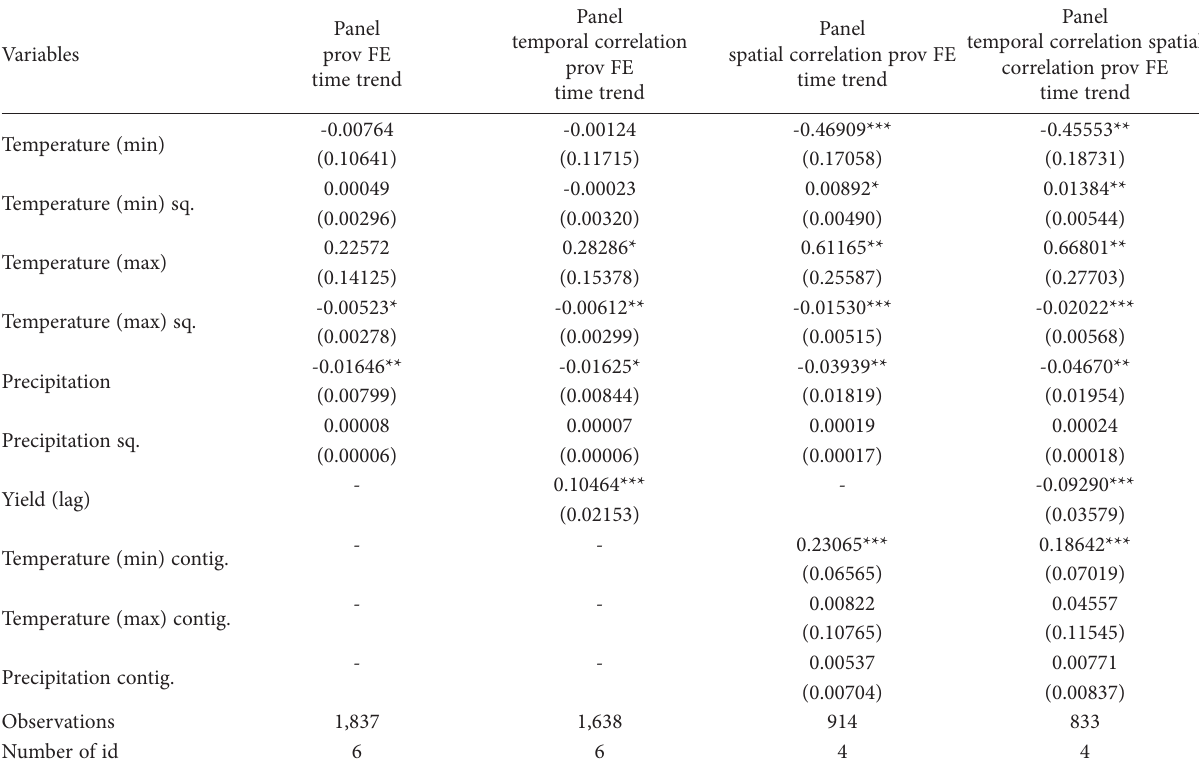
Table 4. Effects of weather variables on durum wheat